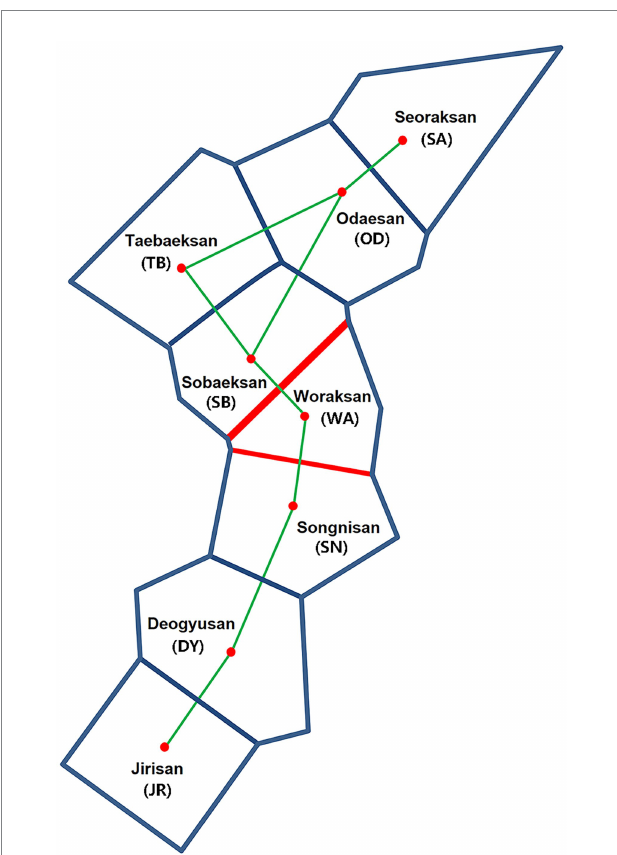
FIGURE 5 Genetic barriers (shown by red lines) of Apodemus agrarius populations ranked in an order of impermeability (indicated by line thickness) using Delaunay triangulation (connection of each national park; green lines) and Voronoi tessellation (GPS information for each national park; blue lines) as implemented in BARRIER, based on F ST values of mtDNA and